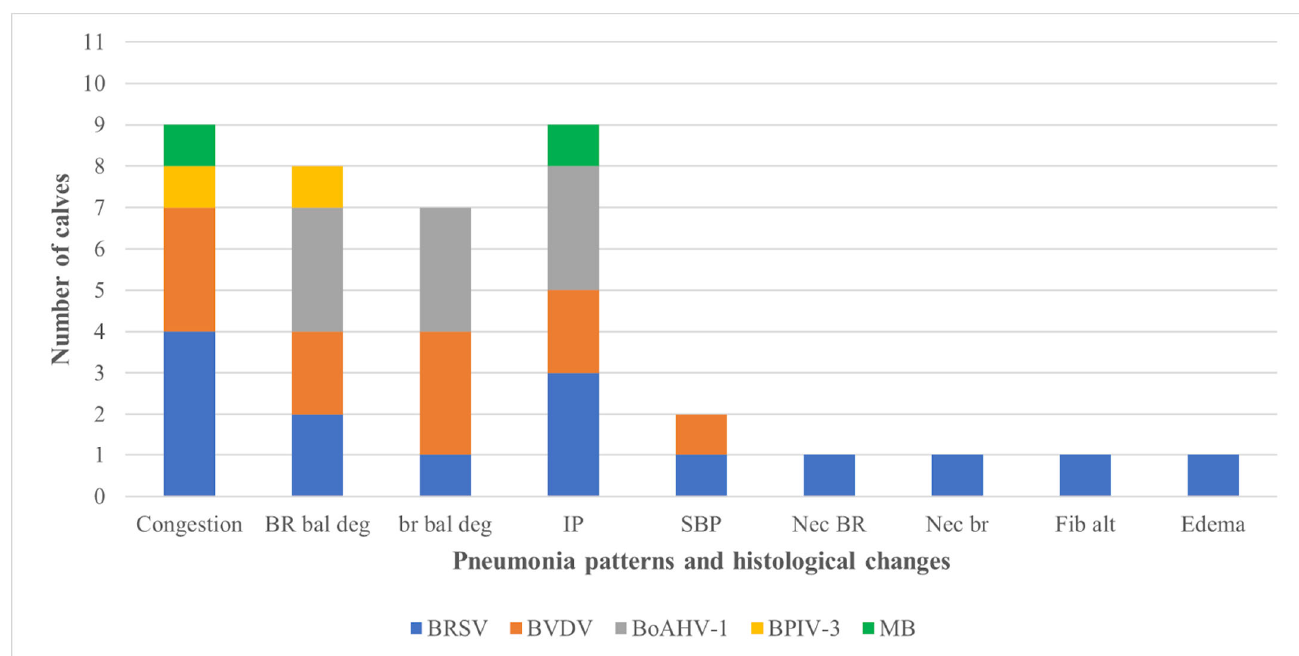
Figure 2. Relationship between pneumonic patterns and histological changes with the associated infected agent identified by immunohistochemistry in the lungs of aborted bovine fetuses. Footnote: BoAHV1: bovine alphaherpesvirus 1; BPIV-3: bovine parainfluenza virus 3; BRSV: bovine respiratory syncytial virus; BVDV: bovine viral diarrhea virus; M. bovis: Mycoplasma bovis. IP, interstitial pneumonia; BR bal deg, bronchial epithelial ballooning degeneration; SBP, suppurative bronchopneumonia; br bal deg, bronchiolar epithelial ballooning degeneration; BR nec, bronchial epithelial necrosis; br nec, bronchiolar epithelial necrosis; Fib Alt, fibrinoid alteration.